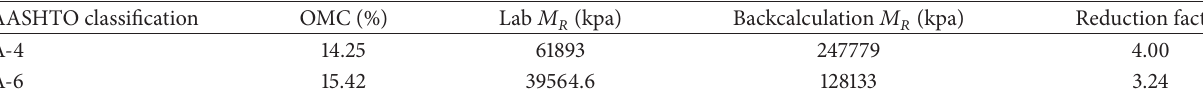
Table 6: Comparison between lab and backcalculated resilient modulus.